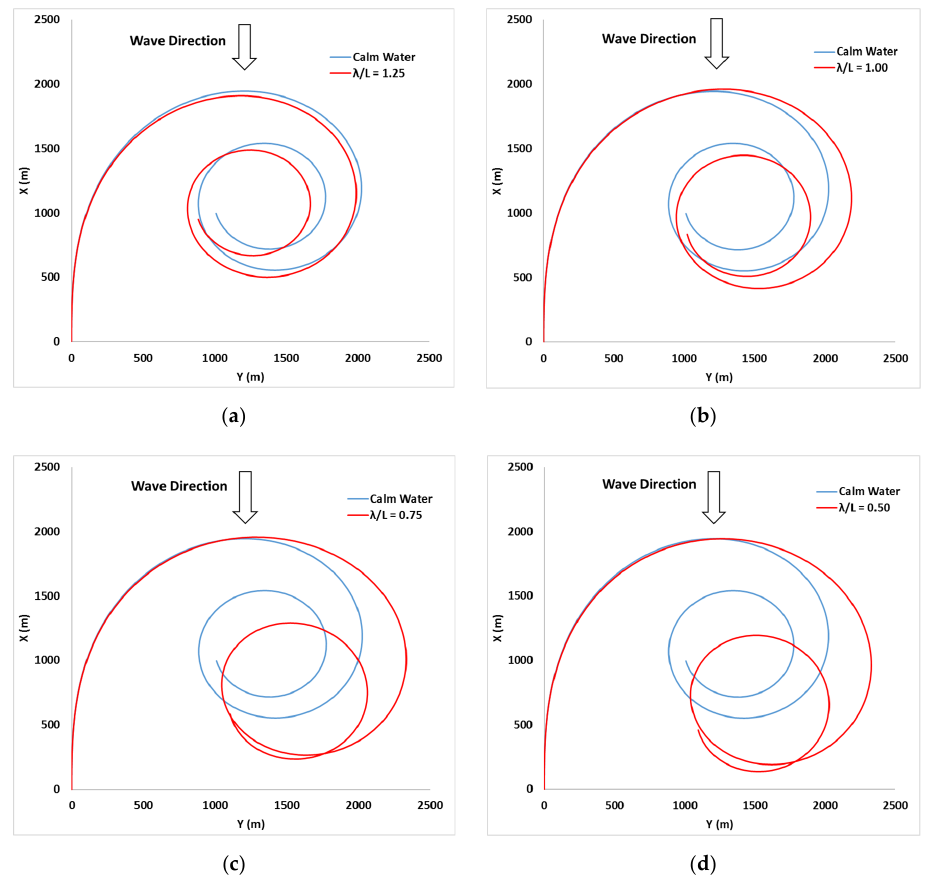
Figure 5. KVLCC’s starboard-side 35 deg turning trajectories in regular waves with 180 deg at t = 0 and four di ff erent ratios between wave length and vessel length λ : ( a ) λ = 1.25; ( b ) λ = 1; ( c ) λ = 0.75; ( d ) λ =